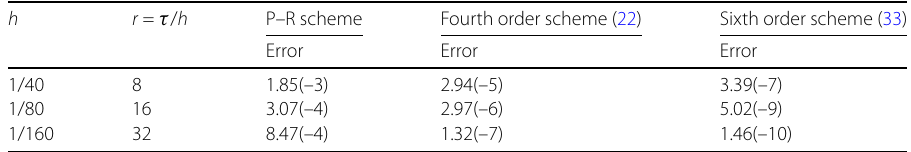
Table 5 L 2 -norm error for Problem 2 with τ = 0.2 at T =